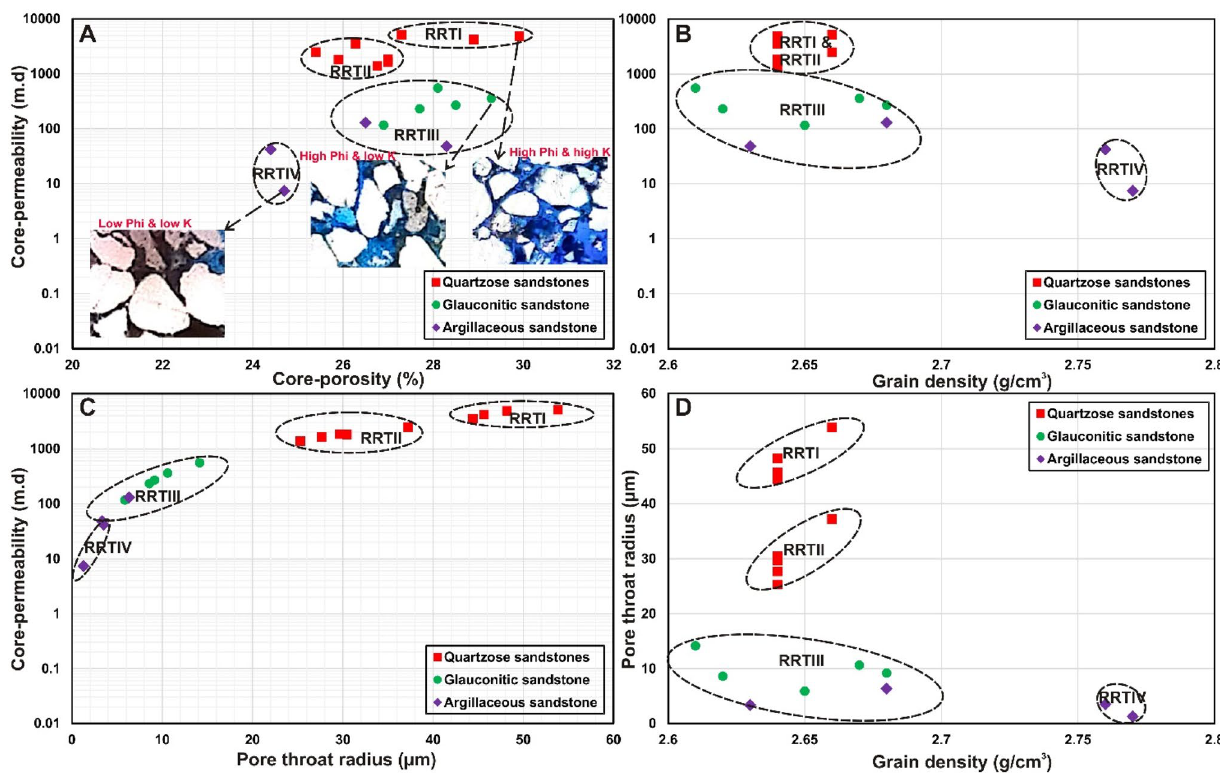
Fig. 11 Conventional core analysis (CCA) cross-plots revealing the presence of four different reservoir rock types (RRT) in the Abu Madi fluvial unit Table 2 Quantitative petrophysical parameters for each reservoir rock type